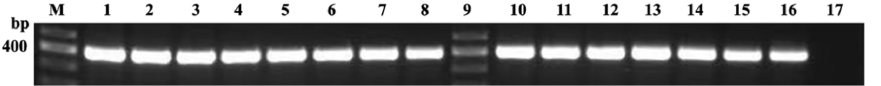
Figure 5. Detection results of GPV nanoPCR in clinical samples. Lane M and 9, DL 1,000 Marker;